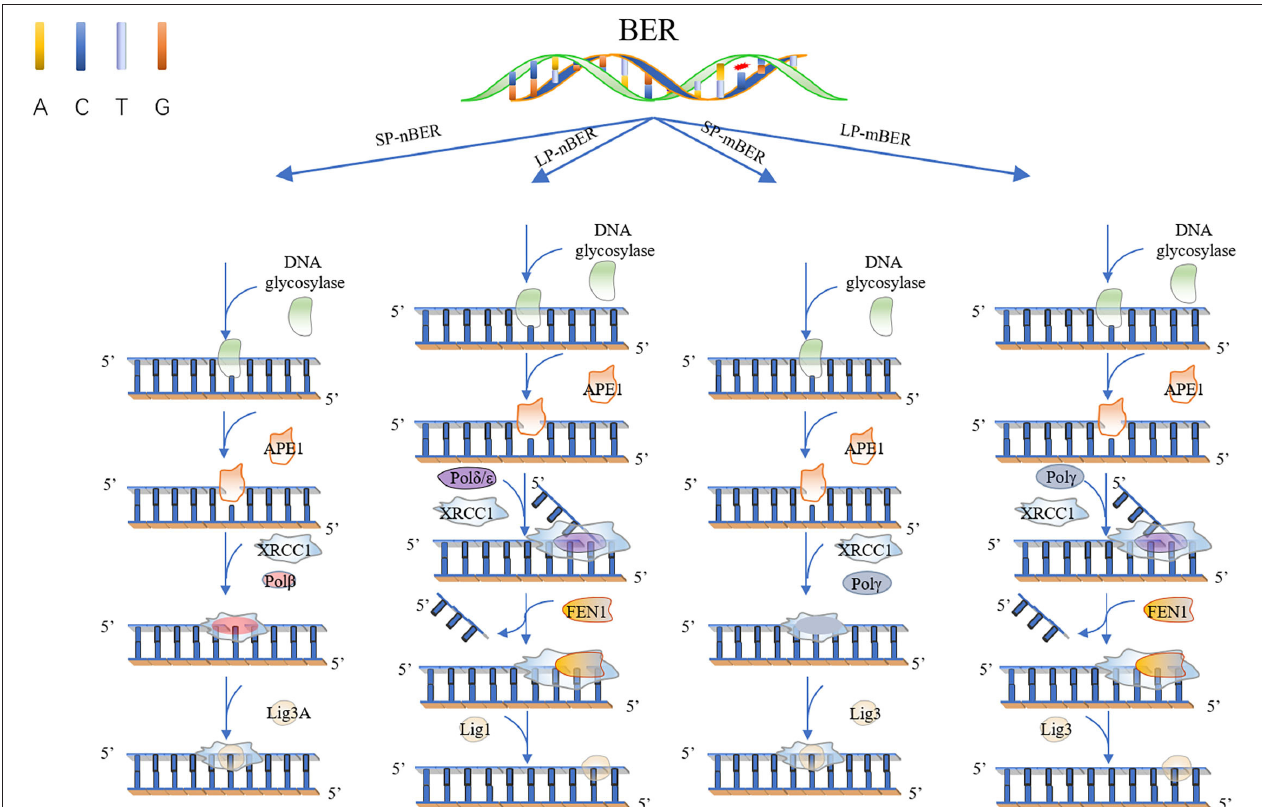
FIGURE 1 | Base excision repair. In short patch nuclear BER (SP-nBER), DNA glycosylase can cut the chemical bond between nucleotide bases and ribose to release a complete DNA phosphoribose chain. This process will form an purine or pyrimidine (AP) site. APE1 cleaves the 5’position of the phosphodiester chain at the AP